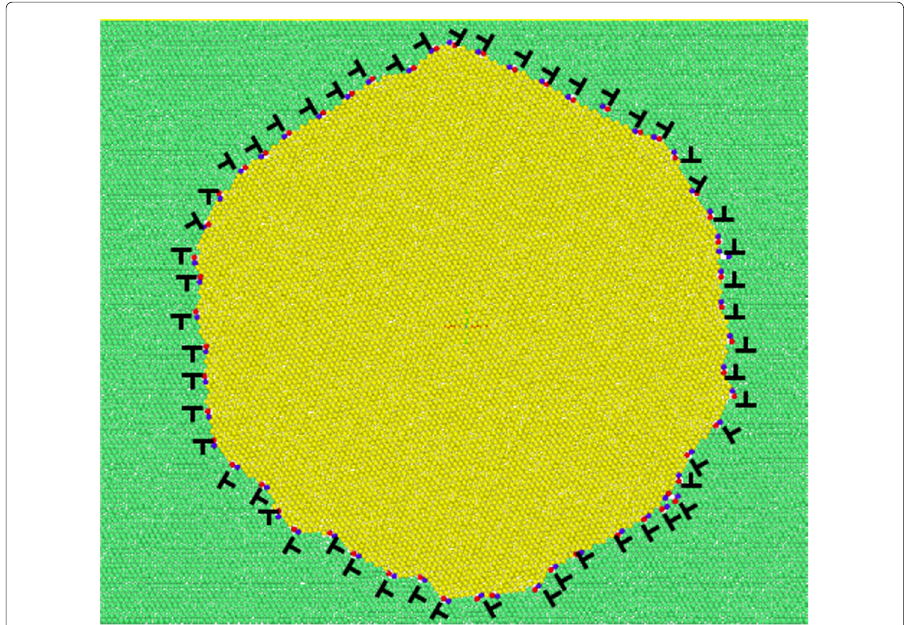
Fig. 3 Facet formation during grain shrinkage for an initial misorentation θ = 10 ◦ . The matrix is represented in green and the grain in yellow. Each dislocation is shown by a 5-7 pair (blue-red). Each facet is composed of a set of dislocations having the same Burgers